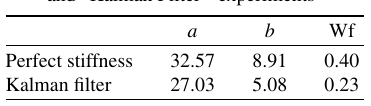
Table 4 Results obtained in the “Perfect